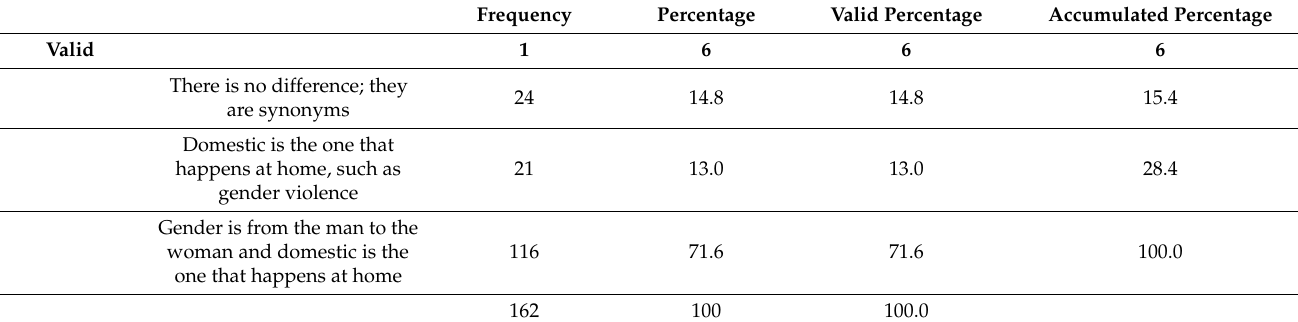
Table 6. Descriptive statistics of the frequencies of question 4.